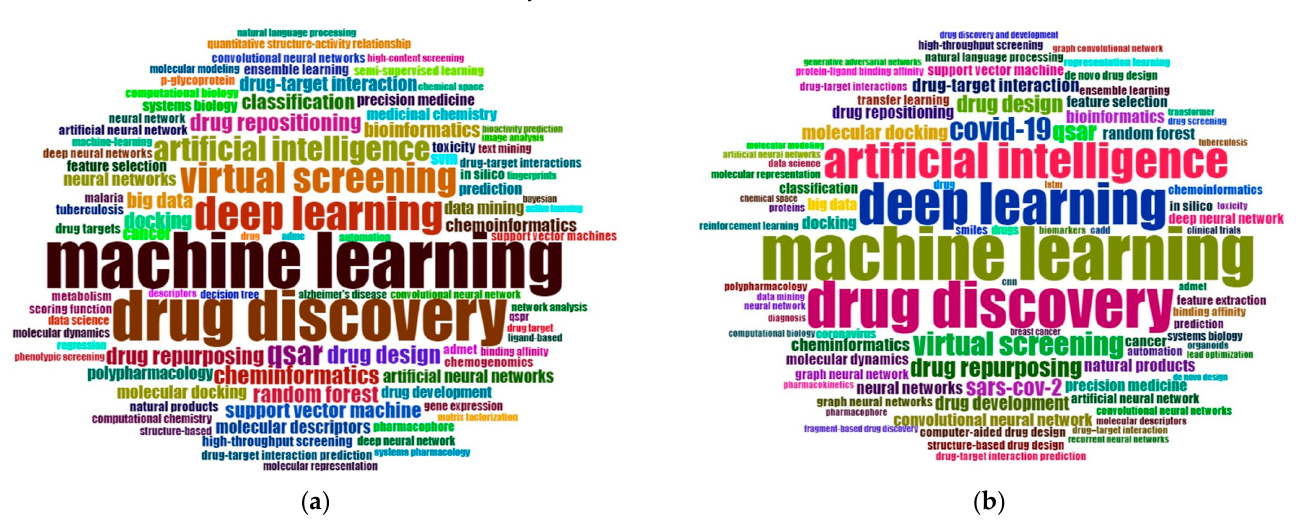
Figure 4. Word clouds of the most frequently appearing author keywords: ( a ) years 2015–2019 (1197 articles) and ( b ) years 2020–2022 (1789 articles). Table 9. Overview of the time periods.